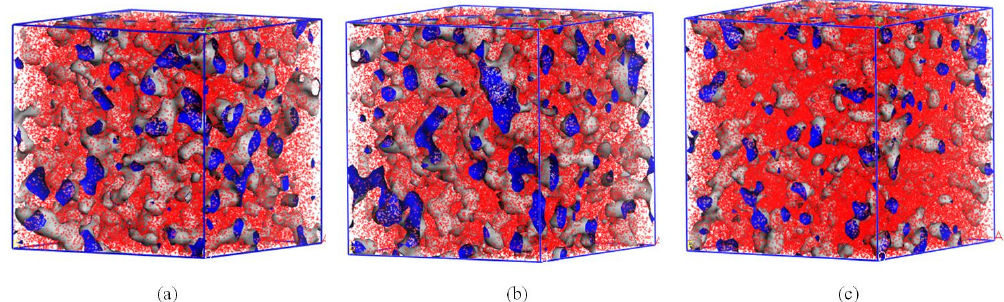
Figure 13. Free volume distributions among asphalts: ( a ) virgin asphalt (37.3%); ( b ) aged asphalt (36.4%); ( c ) RAM (32.1%) (occupied volume: red; free volume: blue; Connelly surface: gray).